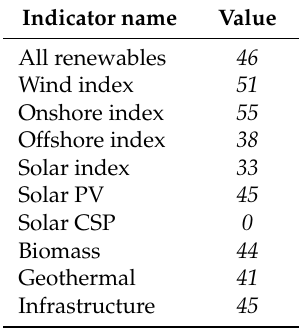
Table 1. Romania scores in RECAI Table 1 . Romania scores in RECAI rankings.